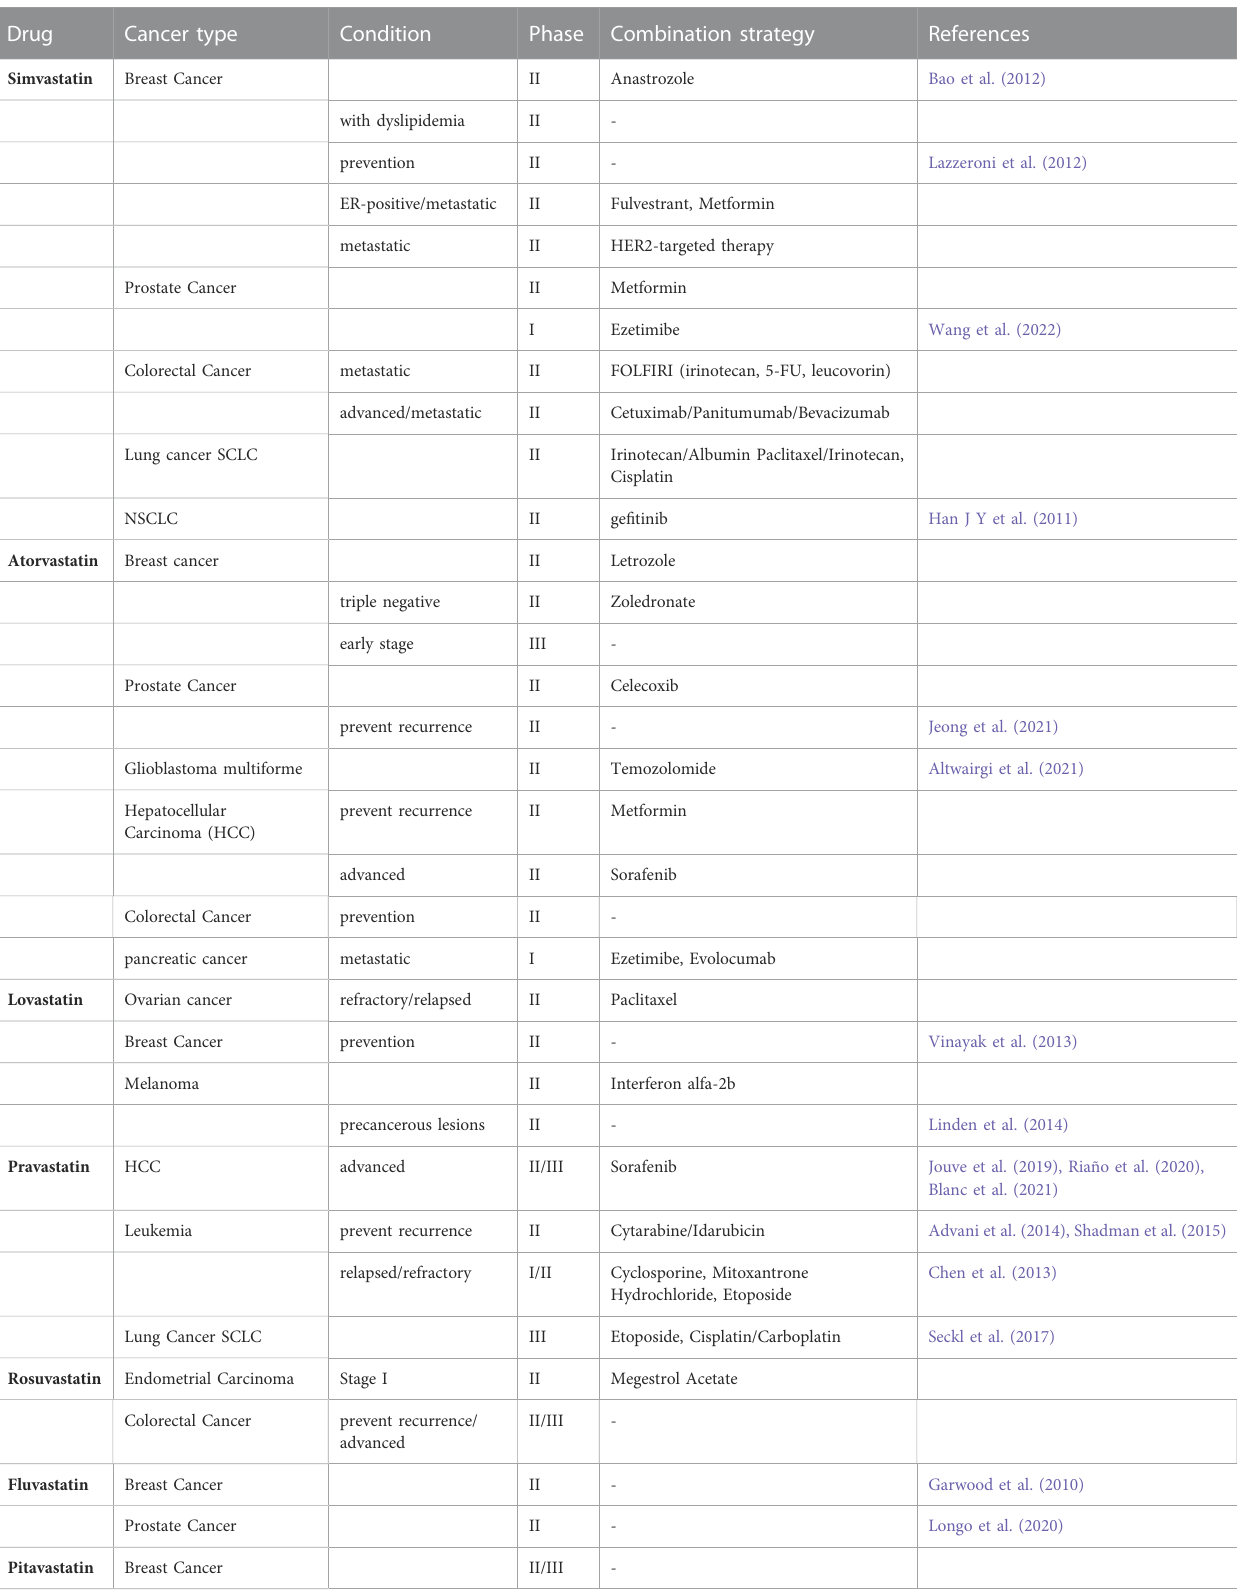
TABLE 2 Clinical trials of statins in